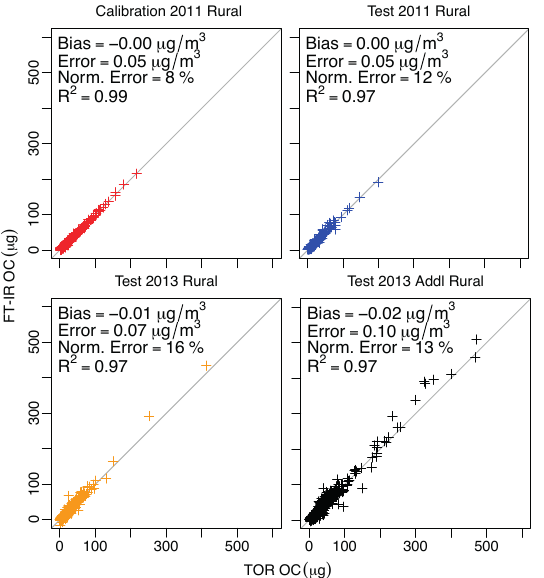
Figure 4. Scatter plots and performance metrics between FT-IR OC and TOR OC for the rural sites of the four data sets described in Sect. 2.1. Concentration units of µgm − 3 for bias and error are based on the IMPROVE nominal volume of 32.8m 3 .